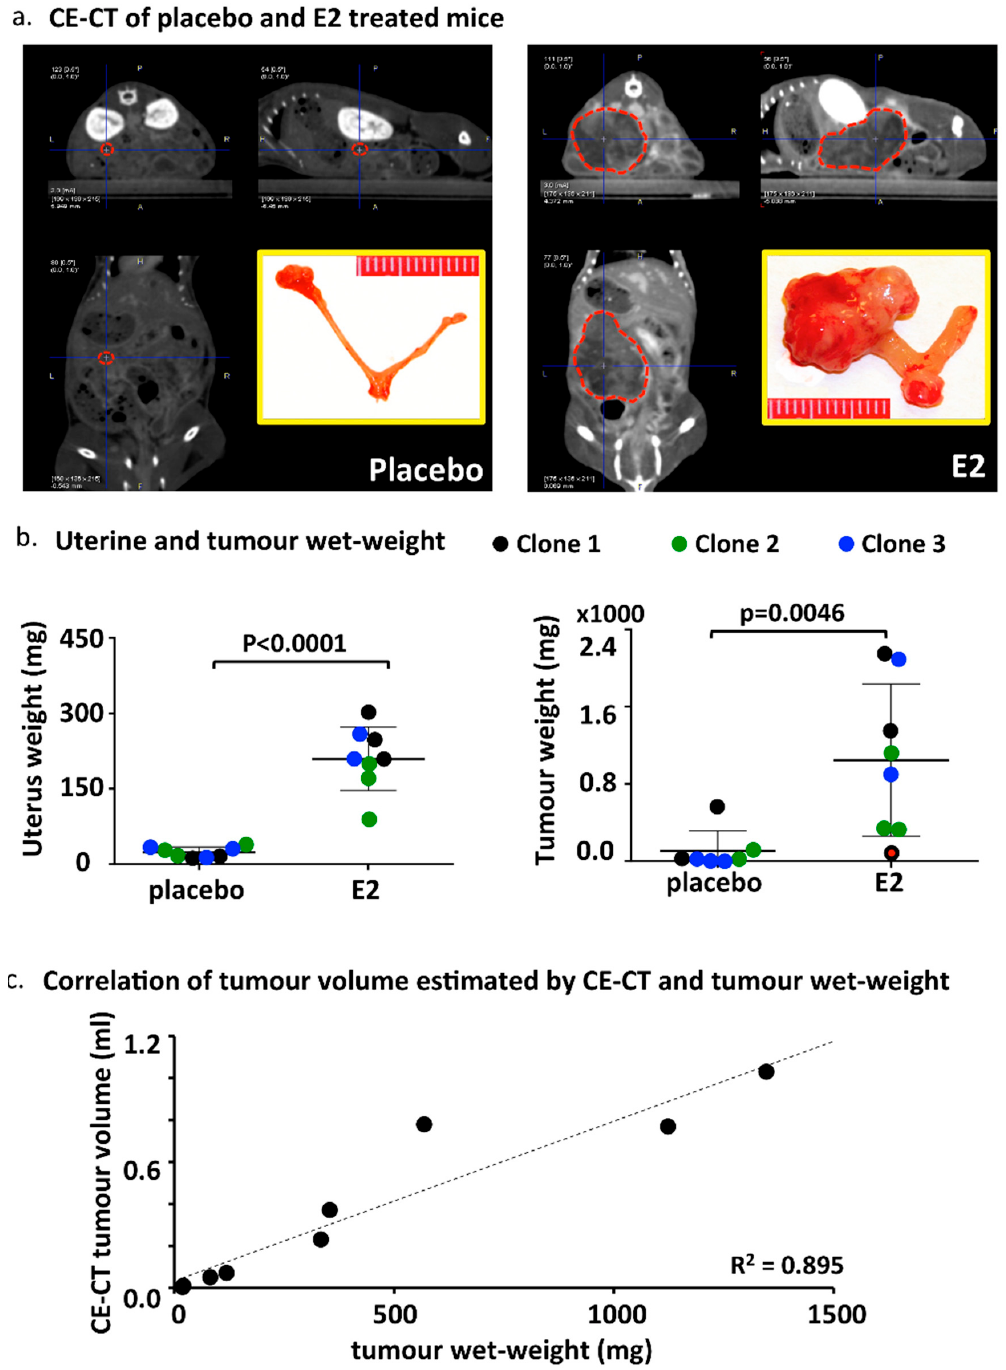
Figure 2. Tumor growth determined by CE-CT and wet-weight at sacrifice. ( a ) Representative CE-CT scan images centered by the blue cross at the center of the tumour (indicated by the red dotted line). The yellow-bordered inset shows the size of the uterus and the tumour surgically removed at sacrifice. ( b ) Uterine and tumour wet-weight in the E2 treated and placebo groups. The color codes indicate the different cell clones used. The red dot in the right panel shows the tumour weight of an E2 treated mouse from clone 1 with no proper tumour engraftment (no BLI signal at the moment of E2/placebo supplementation, week 0) probably due to sub-optimal cell injection (see also Table 3). p values are computed using t -test (outlier included). ( c ) Correlation between tumour volume estimated by CE-CT and the wet-weight of surgically removed tumours at sacrifice.